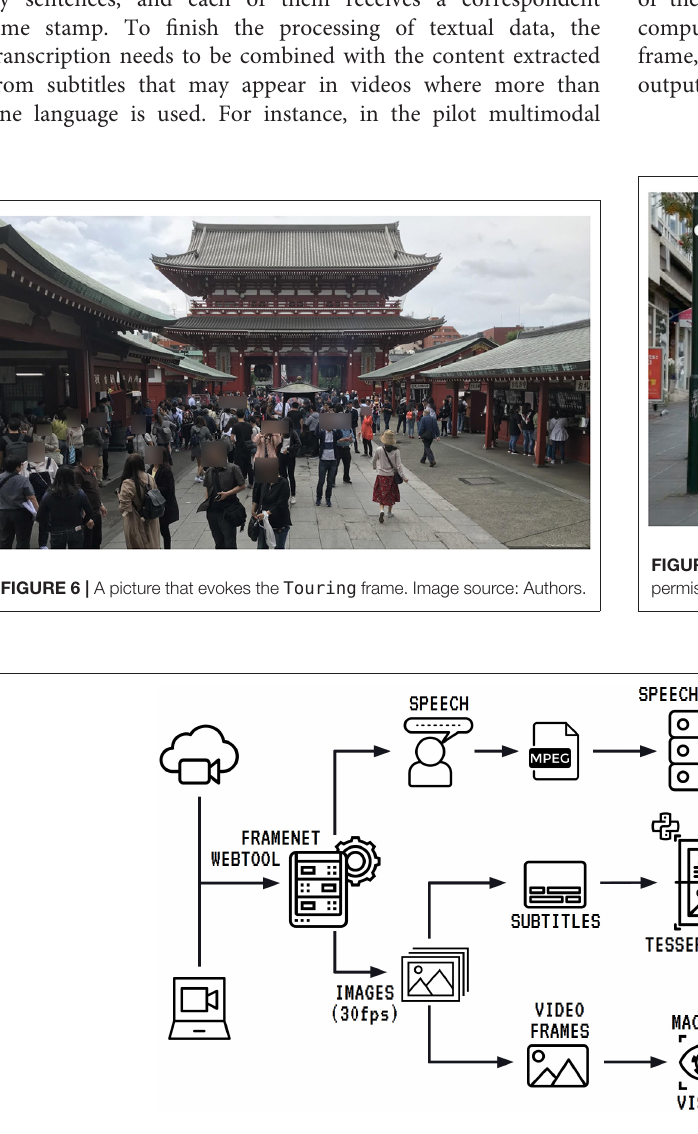
FIGURE 7 | Multimodal corpus import and processing